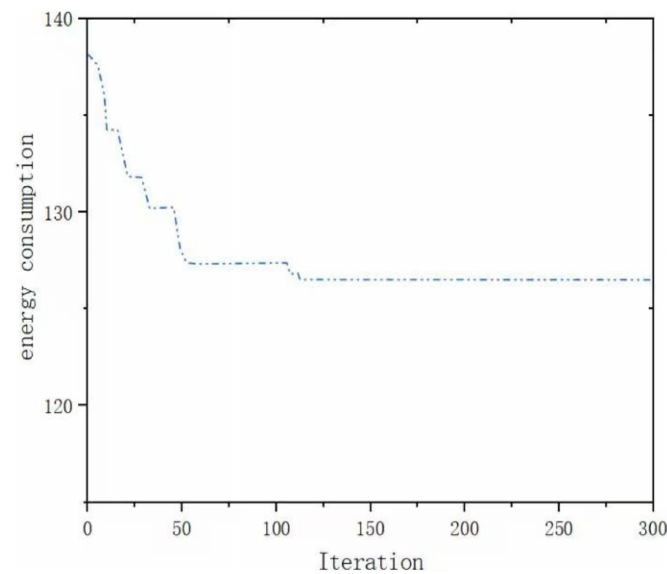
Figure 7. Energy consumption iterative convergence graph for blank dimension 3.